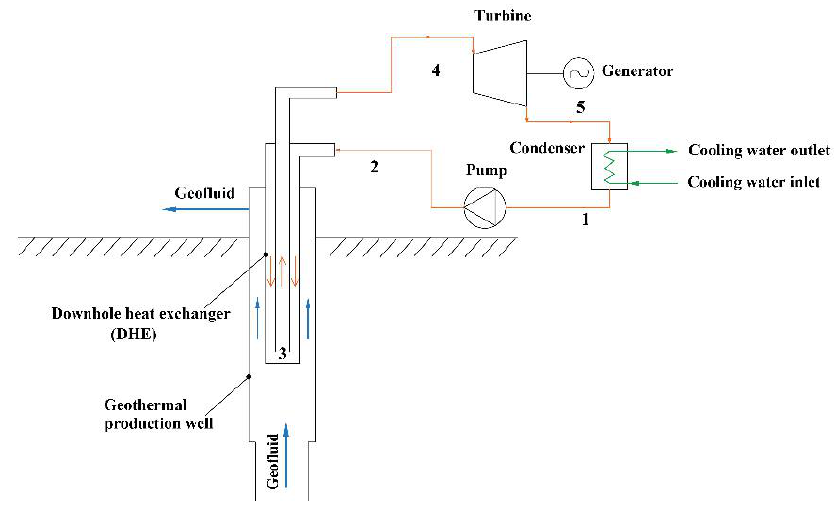
Figure 1. Schematic diagram of the investigated geothermal power generation system.